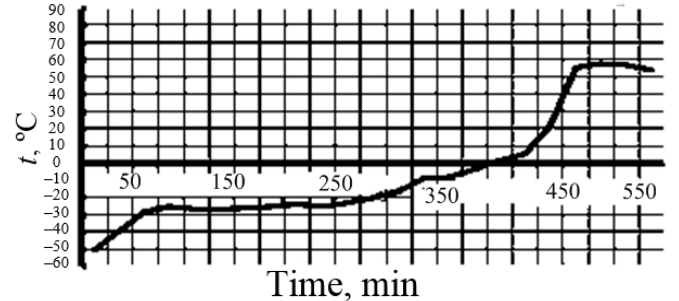
Figure 4. Dependence of pressure on time during sublimation upon receipt of a sample of nanopowder.